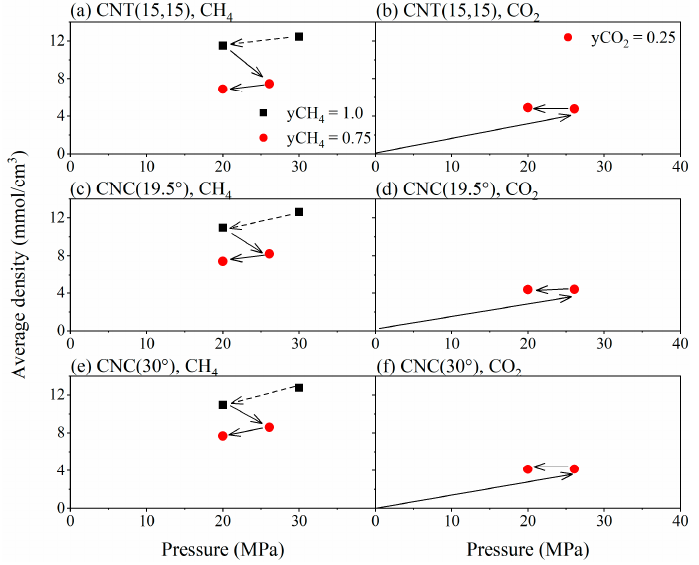
Figure 5. Density distribution of CH 4 (left) and CO 2 (right) in CNT/CNC. Top to bottom: CNT (15,15), XY plane; CNT (15,15), XZ plane; CNC (19.5 ◦ ), XZ plane; CNC (30 ◦ ), XZ plane. Mole fraction yCH 4 = yCO 2 = 0.5. T = 338 K, P = 20 MPa. ( a ) distribution of CH 4 , CNT (15,15), XY plane, ( b ) distribution of CO 2 , CNT (15,15), XY plane, ( c ) distribution of CH 4 , CNT (15,15), XZ plane, ( d ) dis-tribution of CO 2 , CNT (15,15), XZ plane, ( e ) distribution of CH 4 , CNC (19.5°), XZ plane, ( f ) distri-bution of CO 2 , CNC (19.5°), XZ plane, ( g ) distribution of CH 4 , CNC (30°), XZ plane, ( h ) distribution of CO 2 , CNC (30°), XZ plane.